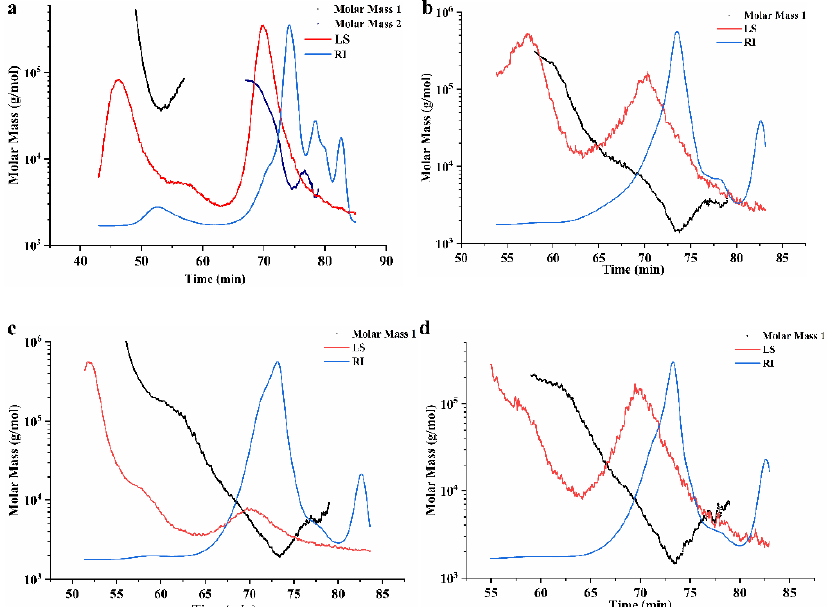
Figure 2. High-performance size exclusion chromatograms of P. notoginseng polysaccharides. The LS refers to the multi-angle laser light scattering signal; RI is the indication difference signal; Molar mass is the molecular weight fitted by two signals. The molecular distribution of PP ( a ), PP3 ( b ), PP5 ( c ), and PP7 ( d ).